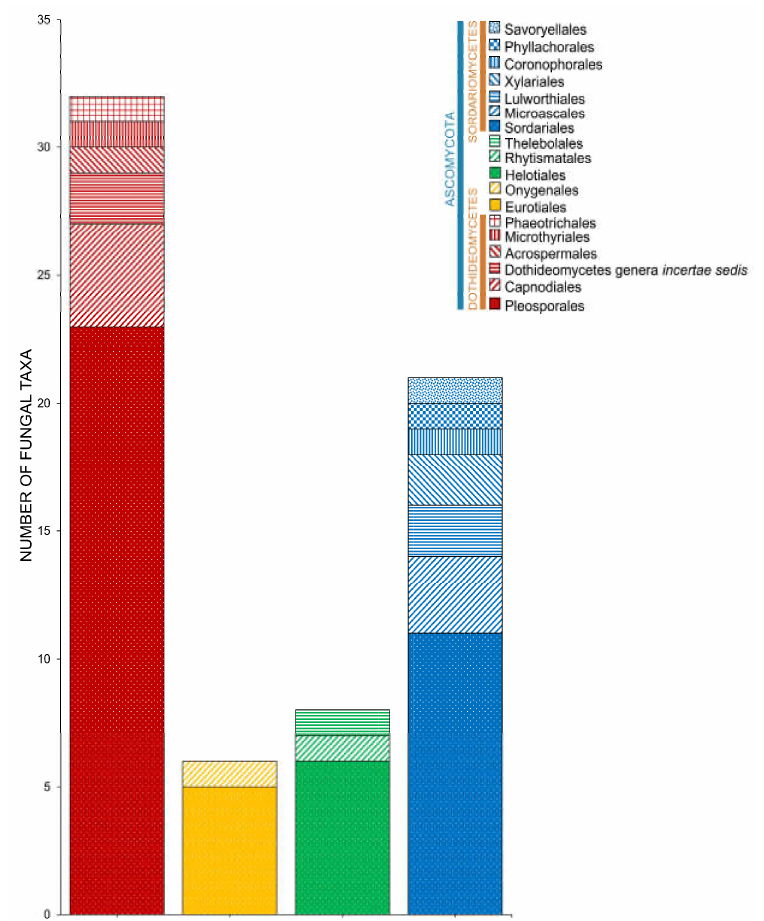
Figure 10. The distribution of fungal taxa associated with Elymus pungens.